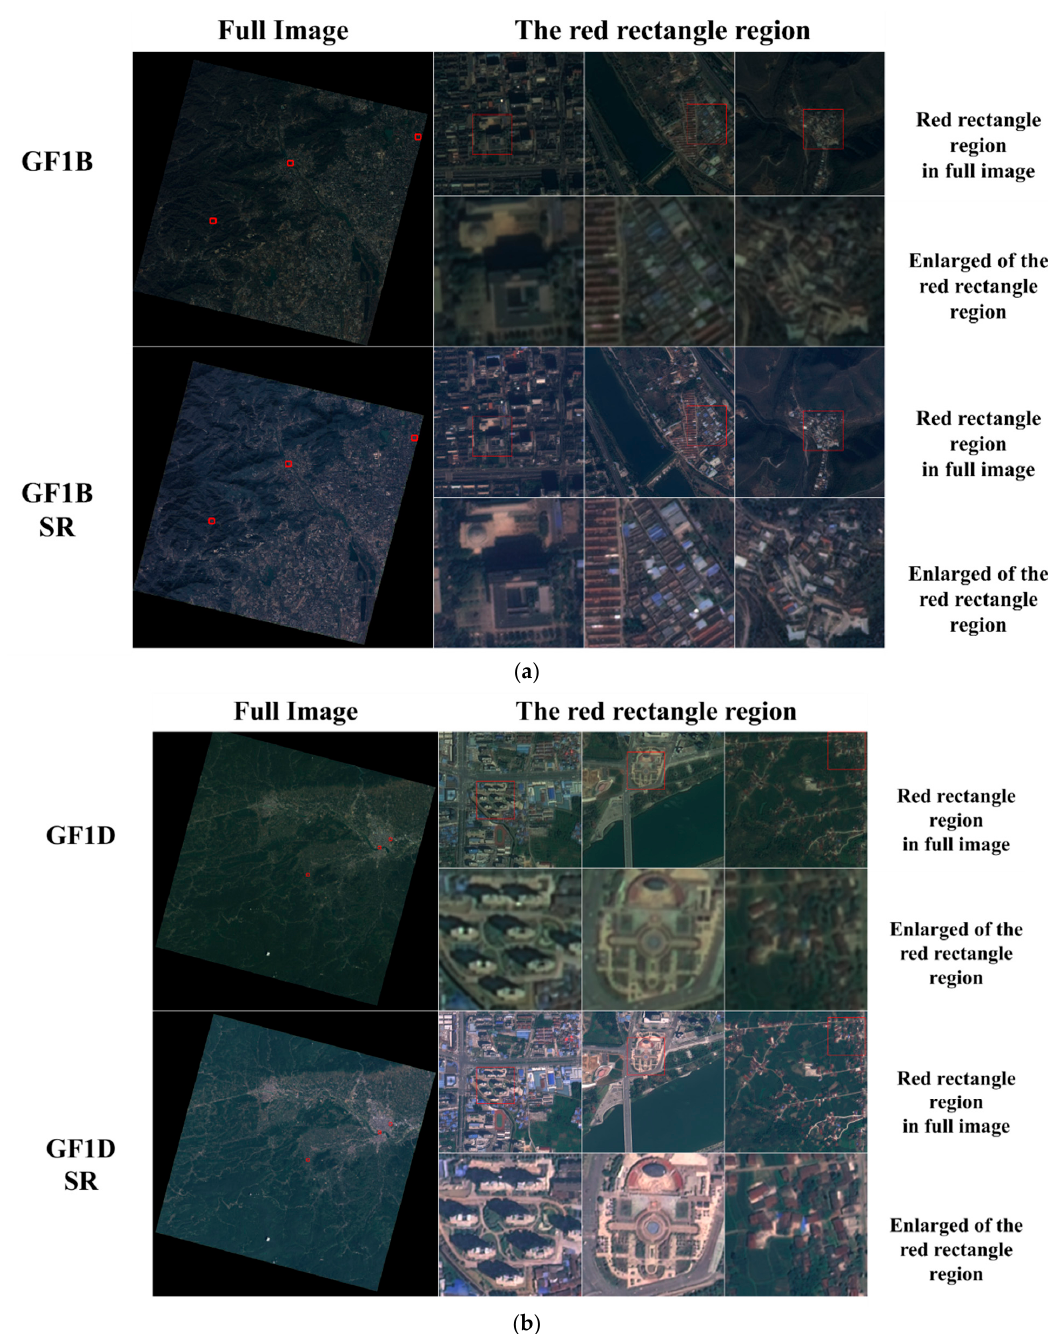
Figure 13. Results of the model migration experiments in different regions and times ( a ) original images of GF1B satellite in Beijing, China, and SR results; ( b ) original images of GF1D satellite in Hanzhong, Shanxi, China, and SR results.